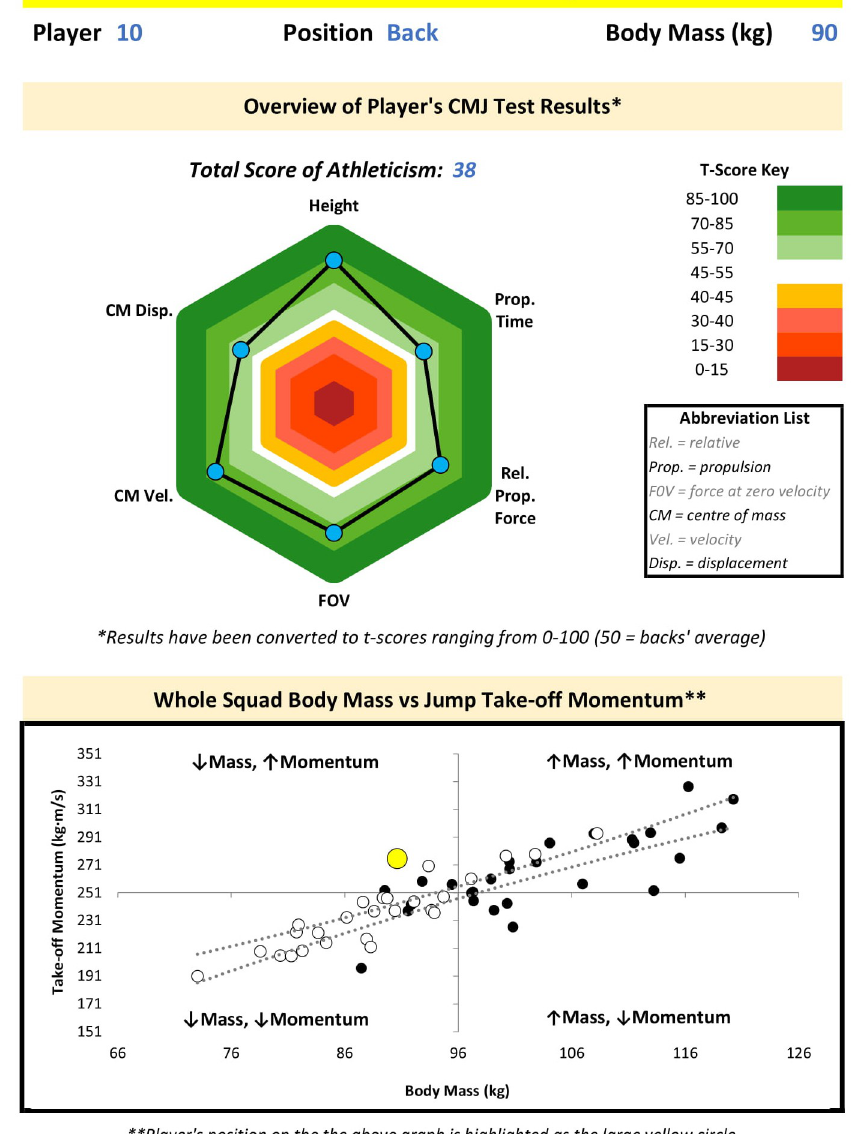
Fig 6. An example one-page report of countermovement jump variables attained by one of the rugby league backs who participated in this study, alongside the body mass and take-off momentum relationship for the whole rugby league squad via a quadrant scatter chart (per Fig 4). T-scores were calculated using squad median value due to sample size.